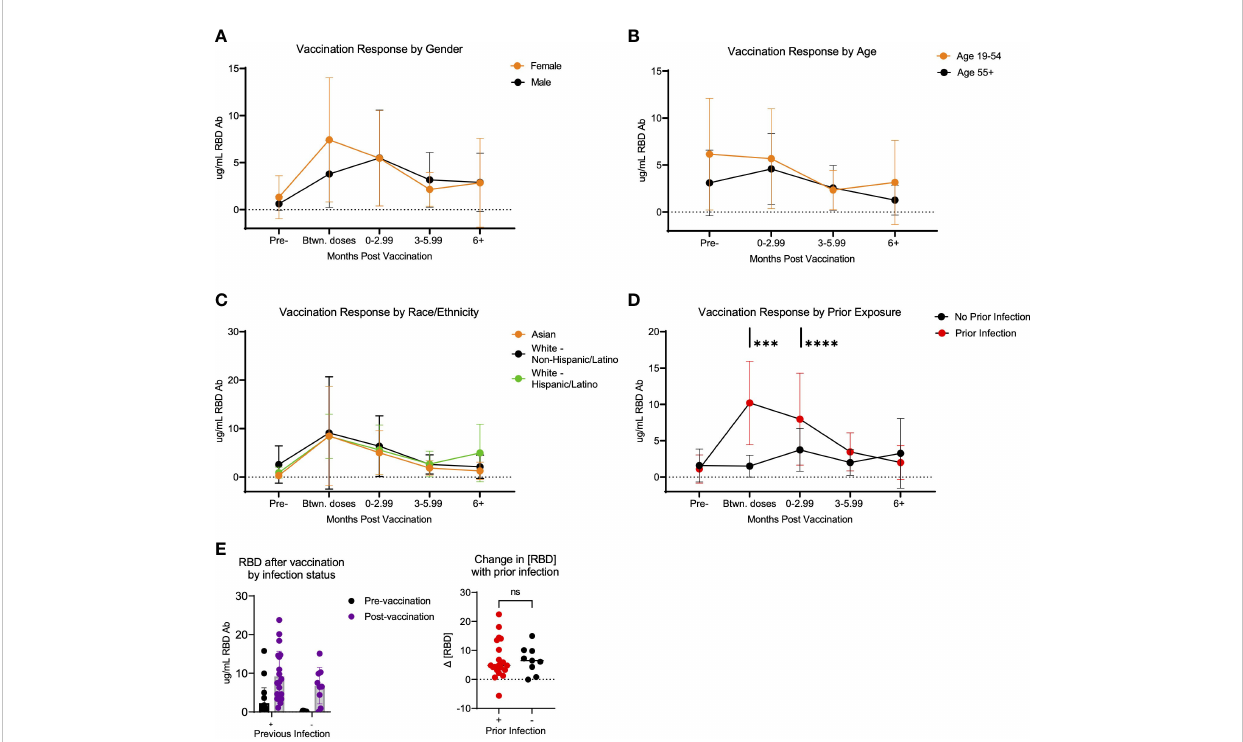
FIGURE 3 Response to SARS-CoV-2 vaccination in LA-SPARTA participants differs with prior infection. (A) shows the concentration of RBD over time according to age. Participants over 55 years of age were compared to all participants below 55 years of age. (B) shows the concentration of RBD over time according to gender. (C) shows the concentration of RBD over time according to race/ethnicity. (D) shows the concentration of RBD over time according to prior infection status before vaccination. (E) shows only the difference in RBD concentration in participants who were vaccinated over the course of the study, using the fi rst available sample after vaccination (regardless of timing after vaccination) according to whether they had a prior infection at enrollment and prior to vaccination. The change in RBD concentration is also shown between the pre-infection and post-infection blood samples. *** designates P >0.001 and **** designates P >0.0001. ns, not signi fi